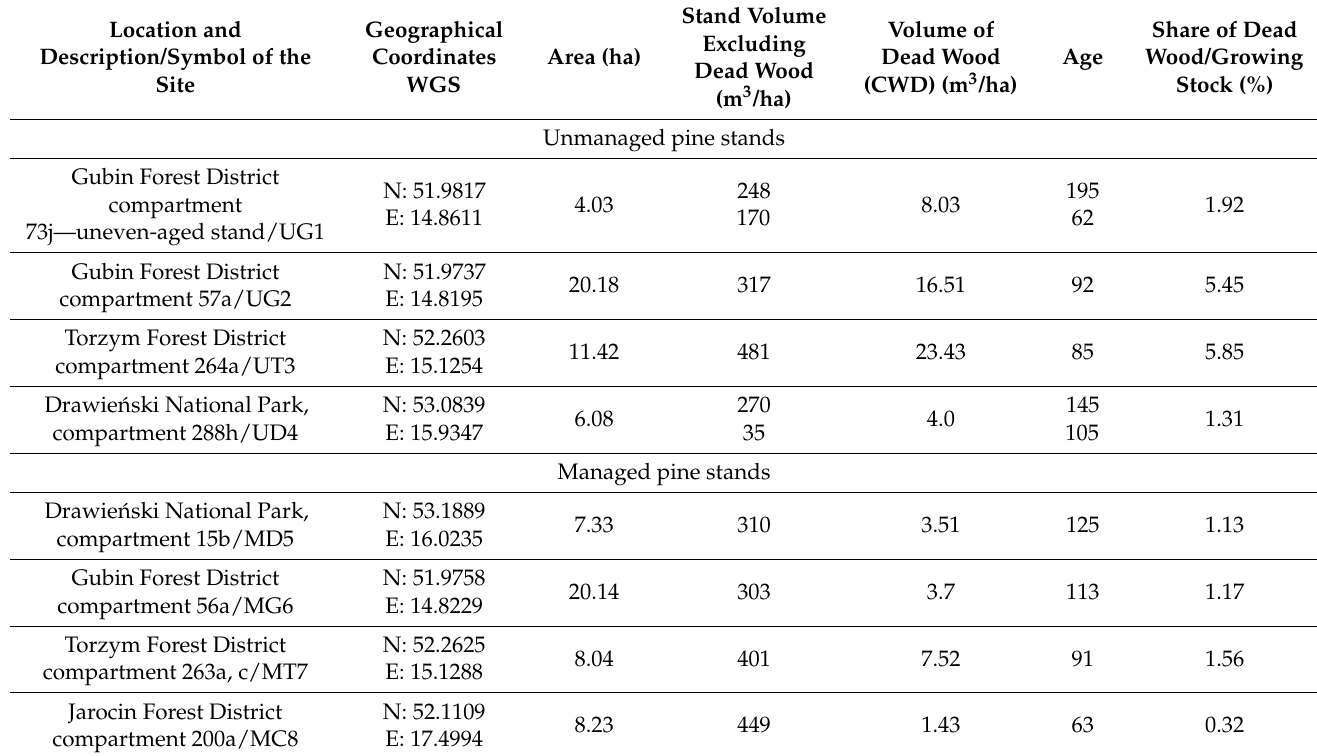
Table 1. Characteristics of experimental sites—unmanaged and managed pine stands in western Poland. Location